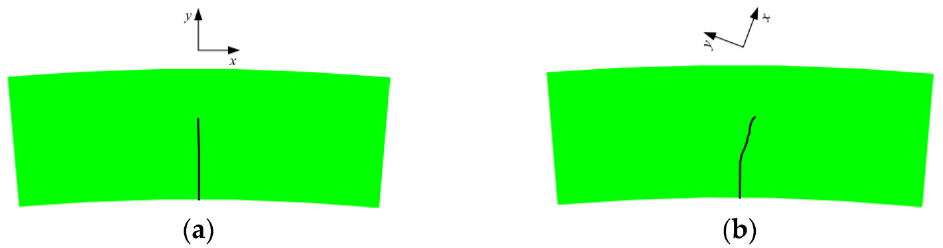
Figure 9. Propagation paths of the cracks: ( a ) arch crown, ( b ) arch waist.